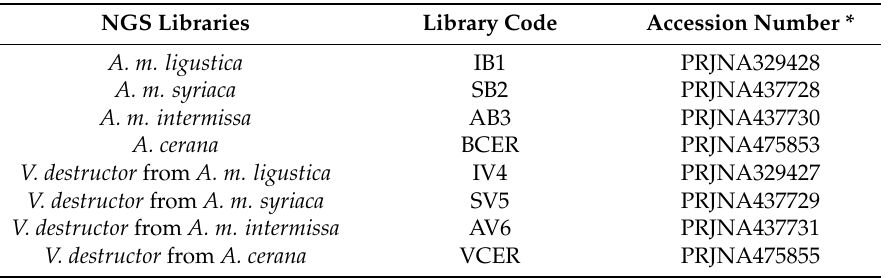
Table 1. Libraries used in this study.